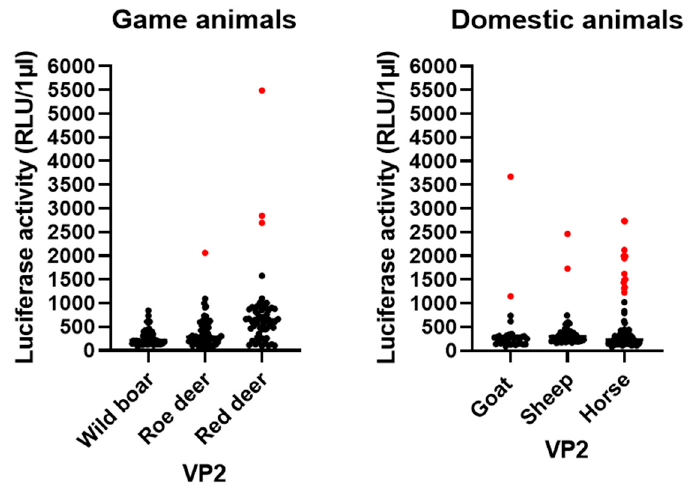
Figure 4. Results of LIPS assay based on 167 animal sera from game animal (wild boar, red deer and roe deer) samples and 179 domestic animal (goat, sheep and horse) samples for the VP2 of ALSV in RLU/µL. Total dataset shown in Tables S4–S9.